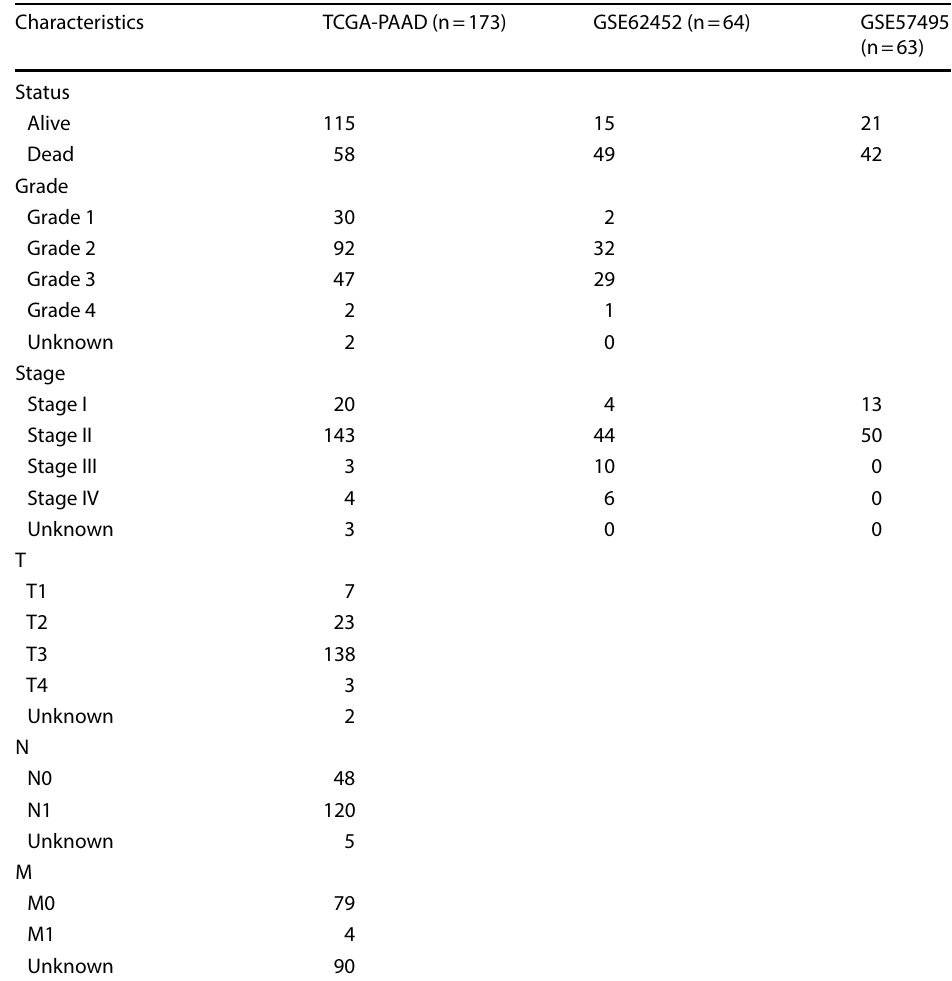
Table 1 The clinicopathological characteristics of